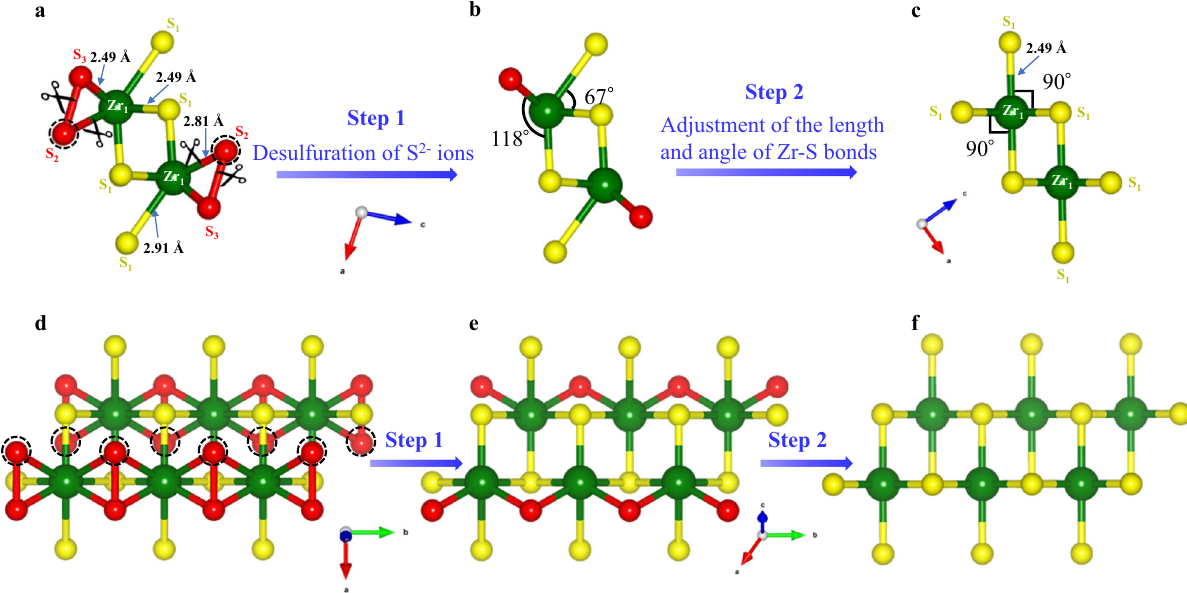
Fig. 1 The transformation of the crystal structure of ZrS 3 into ZrS 2 . The schematic process of the transformation of monoclinic ZrS 3 (ICCD PDF no. 30- 1498) into hexagonal ZrS 2 (ICCD PDF no. 11-0679) from the [010] ( a – c ) and [001] ( d – f ) views. a , d Crystal structure of monolayer ZrS 3 with a boundary of 1 x 3 x 1 from the [010] and [001] views, respectively. b , e Crystal structure of monolayer ZrS 3 after desulfuration of S 2 2 − ions from a and d , respectively. c , f Crystal structure of monolayer ZrS 2 with a boundary of 1 x 3 x 1 from the [010] and [001] views,